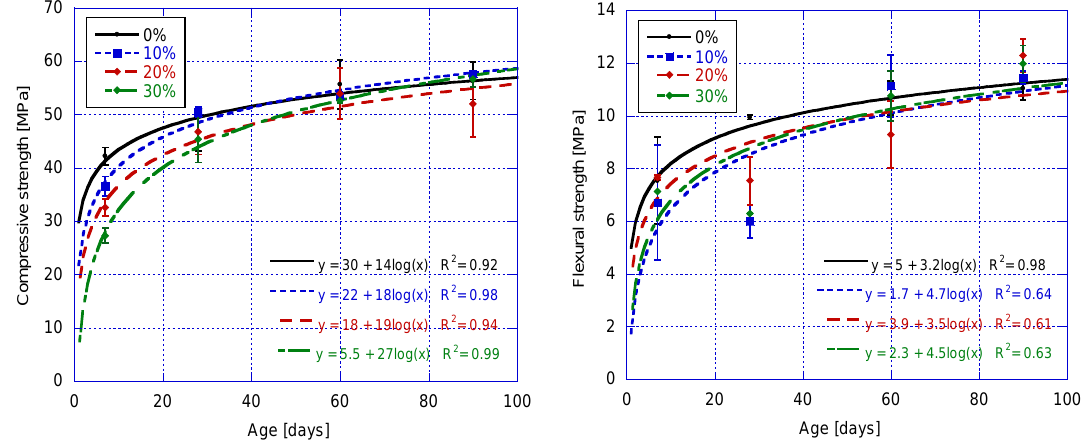
Figure 4. Mechanical properties of mortars with several cement replacements with cupola slag.